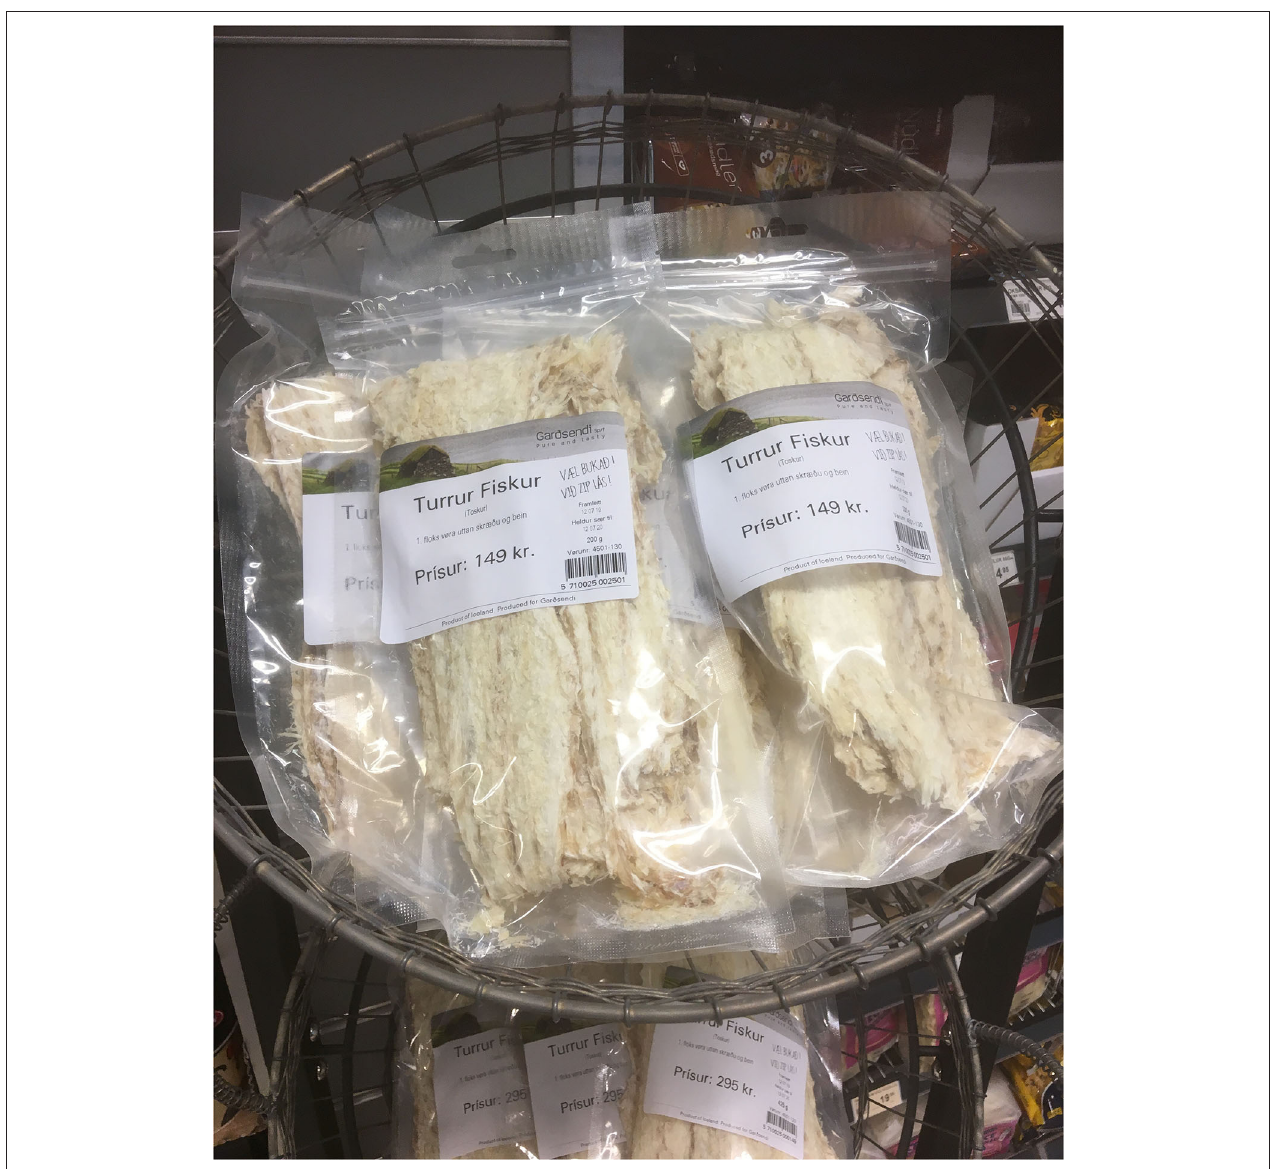
FIGURE 8 | Dried fish (cod) sold in a grocery store in Vestmanna (Photo Ingvar Svanberg, July